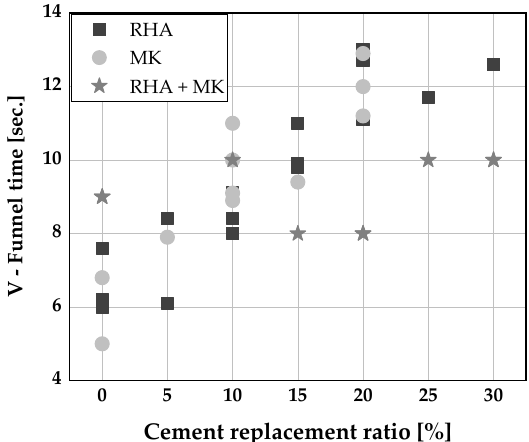
Figure 3. Viscosity of SCC: Chopra et al. [31] , Kannan [30] , Gill [61] , and Madandoust [34].